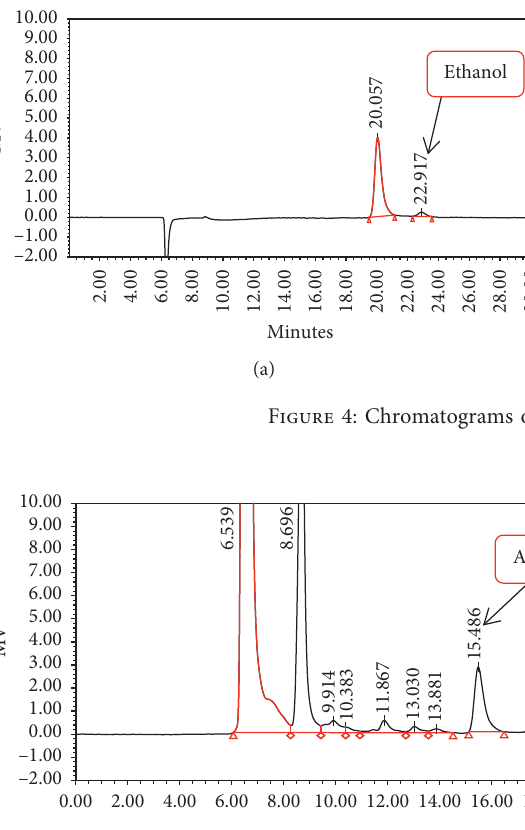
Figure 5: Chromatograms of ethanol and acetic acid contents in products after